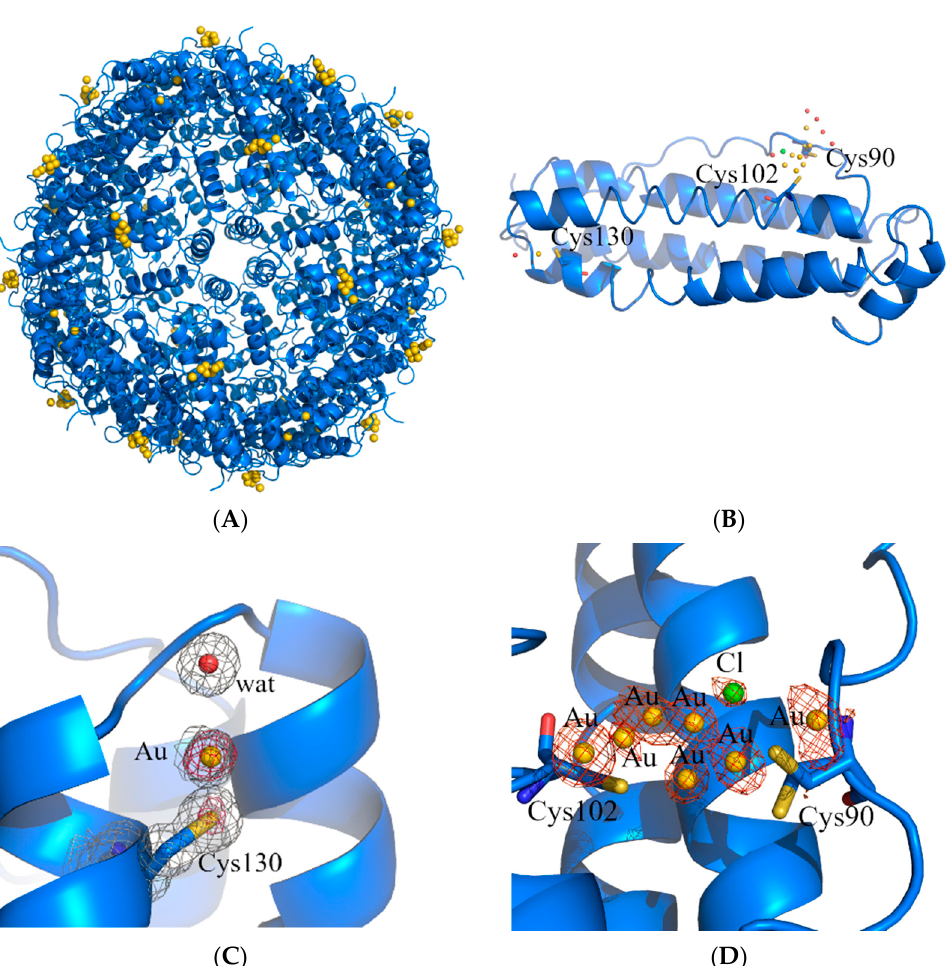
Figure 4. Cartoon representation of the structure of the cage ( A ) and of the single protein chain ( B ) of AF hHFt. The gold binding sites are shown in panels ( C , D ), and 2Fo–Fc and anomalous electron density maps are contoured at 1.0 σ (grey) and 3.0 σ (red), respectively.